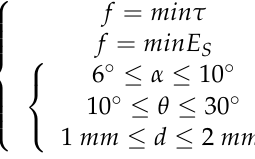
Figure 7. Effects of the sliding cutting angle and cutting gap on specific cutting energy. ( a ) Response surface graph. ( b ) Contour map .